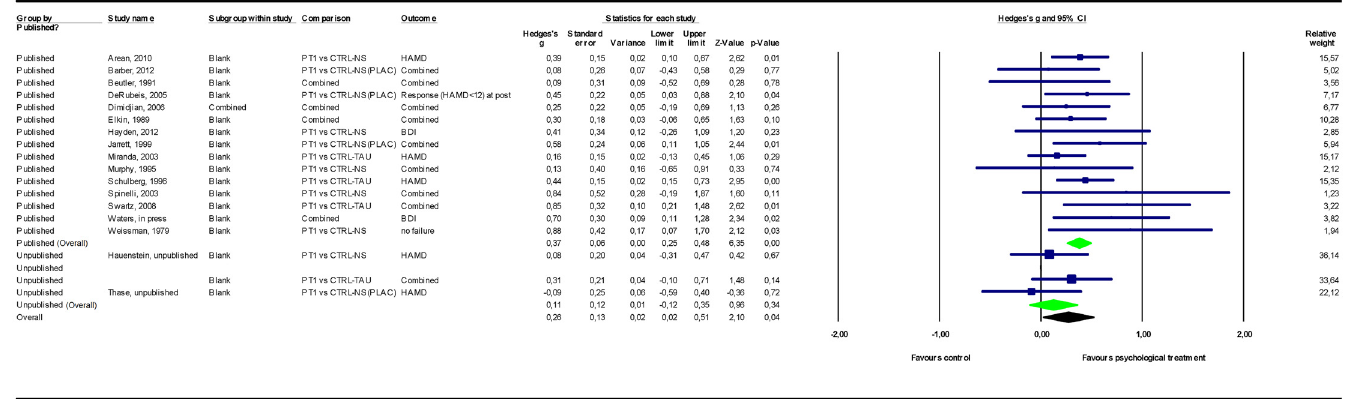
Fig 4. Psychological treatment versus treatment control conditions. Note: Not all results of the unpublished studies are presented at study level, because we did not have permission of the investigators to do so. BDI = Beck Depression Inventory; CTRL-NS = non-specific control condition (psychological placebo); CTRL-NS(PLAC) = pill-placebo control condition; CTRL-TAU = treatment as usual control condition; HAMD = Hamilton Depression Rating Scale; PT = psychological treatment. doi:10.1371/journal.pone.0137864.g004 (S1 Table). The pooled mean effect size of psychological treatment relative to pill-placebo con-